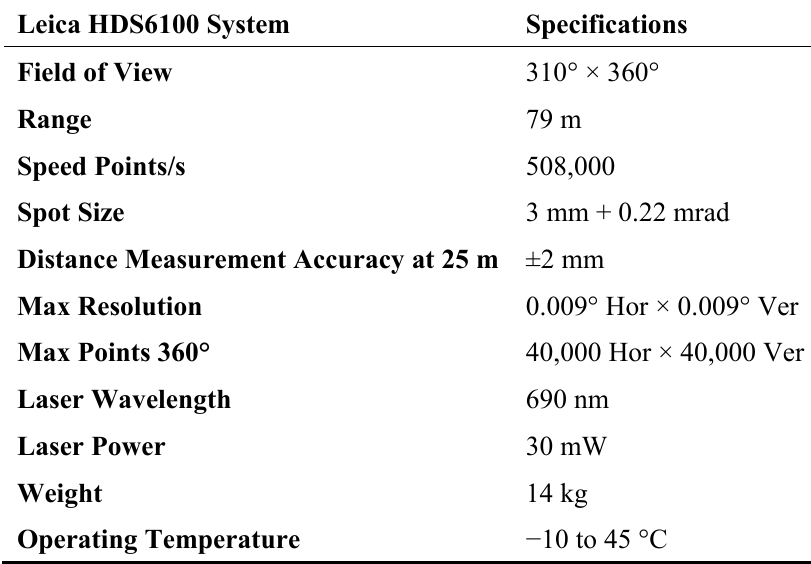
Table 2. Leica HDS6100 TLS system and